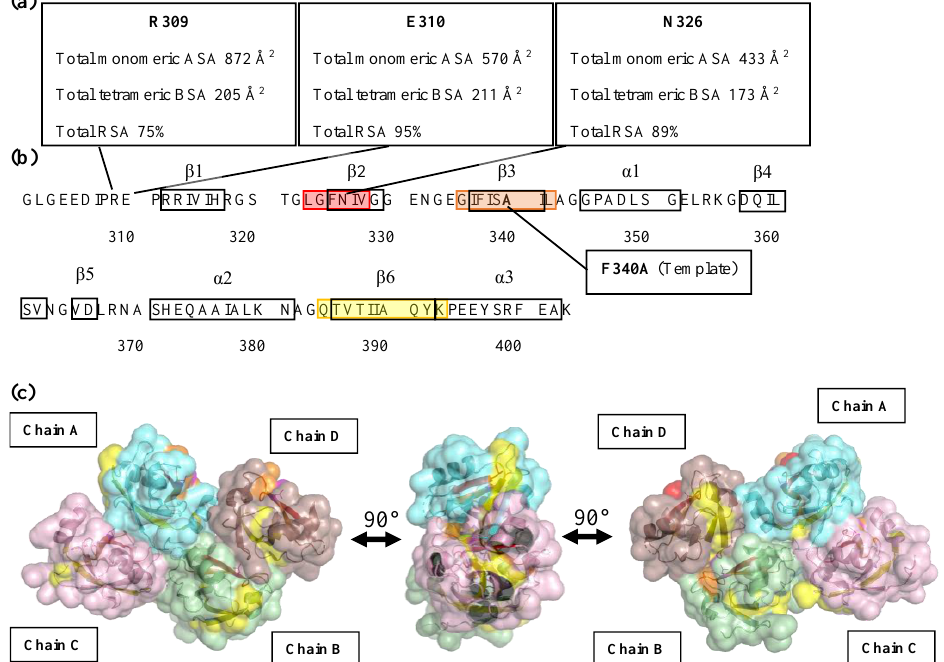
Figure 1. Secondary structure and three-dimensional accessible surface structures of PDZ3-F340A ( a ) Total monomeric accessible surface area (ASA), total tetrameric buried surface area (BSA), and total relative solvent accessible surface area (RSA) values of R309, E310, and N326 residues are shown in square boxes; ( b ) TANGO analysis of β-aggregation (amyloid) prone regions in PDZ3-F340A. The 323–328 residue region crossing the β2 strand is represented in red. The 335–342 residue region crossing the β3 strand is represented in orange. The 384–393 residue region crossing the β6 strand and α-helix 3 at C-terminus is represented in yellow; ( c ) Three images of 90° counter-clockwise views of the PDZ3-F340A tetrameric structure represent the aggregation-prone region on the interface of a tetramer unit cell using Pymol. The color code is the same as in the amino acid sequence. Table 2. Apparent T m and van’t Hoff enthalpy ( ∆ H van’t Hoff ( T m )).